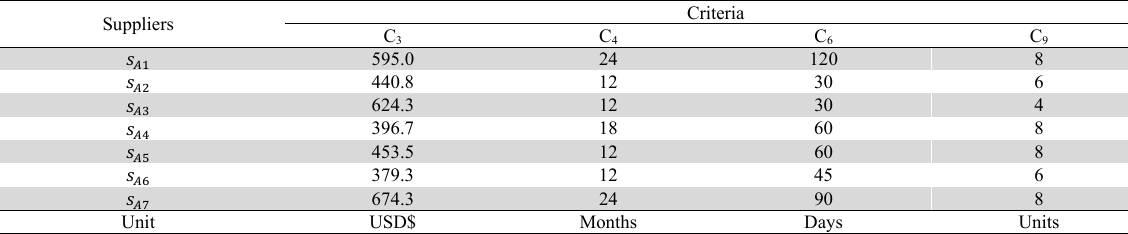
Consequences matrix for case A